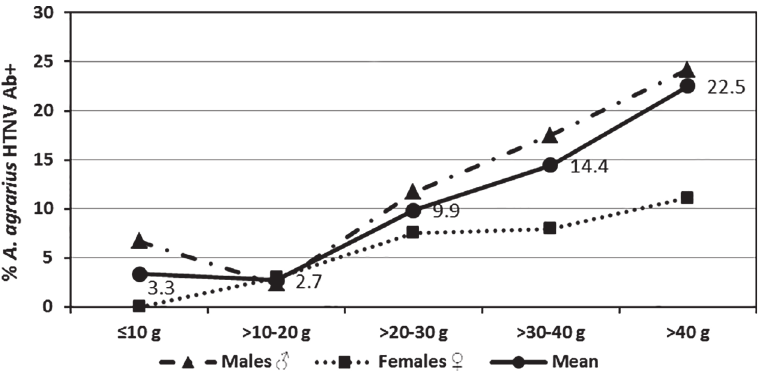
Fig 6. Proportion of male and female A . agrarius , by weight category, that were seropositive for hantaviruses, Nightmare Range, January 2008-December